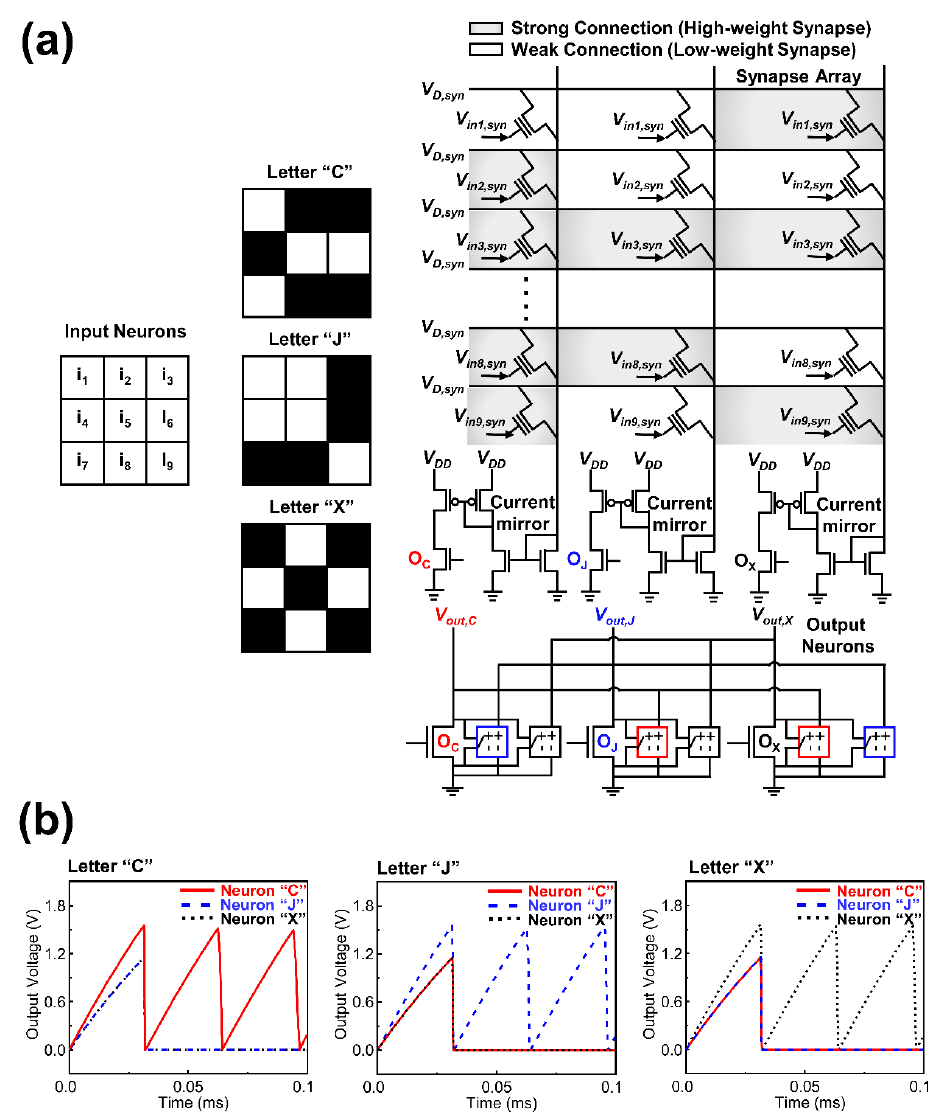
Figure 5. ( a ) Input images for letter recognition with 3 × 3 black-and white pixels and circuit configurations for the neural network system; ( b ) Results of the letter